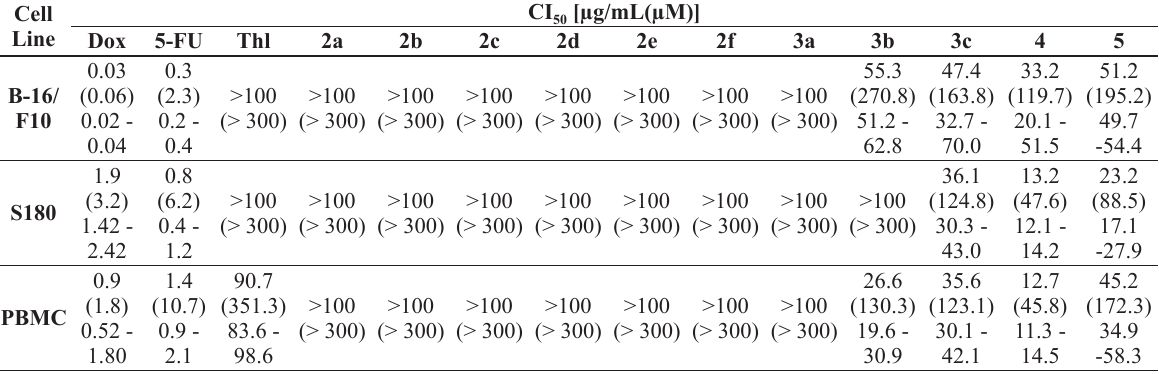
Data are presented as IC values and 95% confidence intervals for murine melanoma (B-16/F10) and primary culture of 50